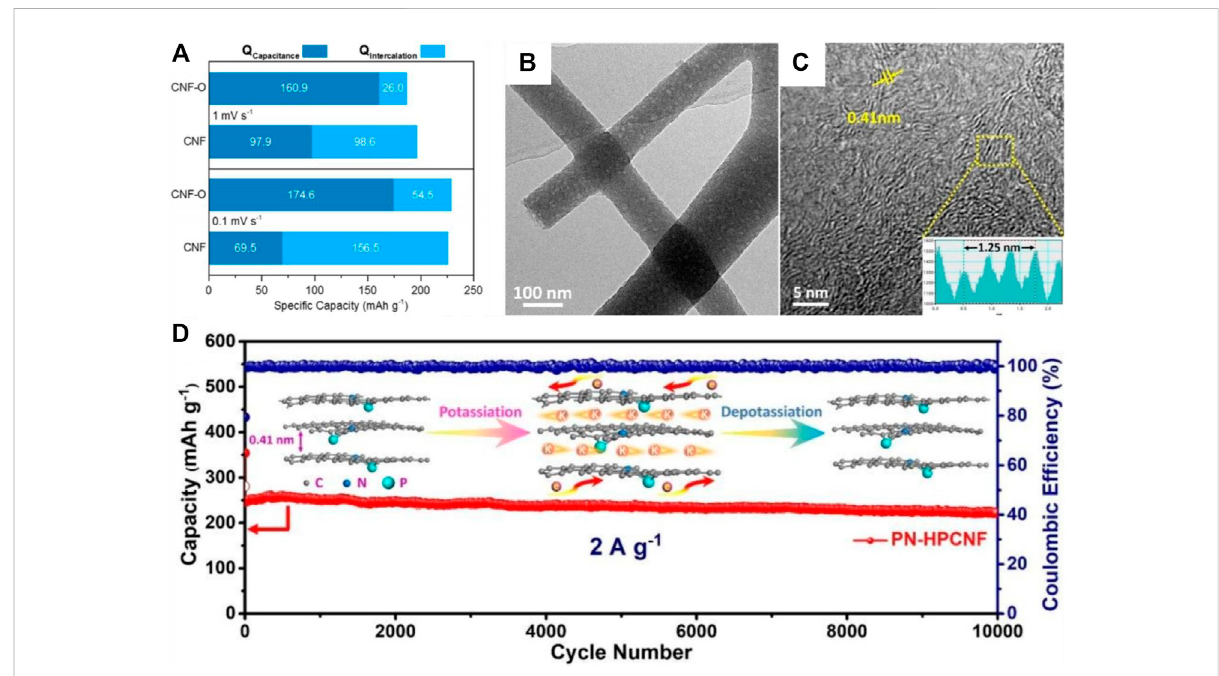
FIGURE 3 (A) Comparison of charge storage mechanism from intercalation and capacitance contributions for CNF and CNF-O at 0.1 and 1 mV s − 1 scan rates (Adams et al., 2017). (B) TEM image of PN-CNF. (C) HRTEM image of PN-HPCNF. (D) Long-term cycling performance of the PN-HPCNF at 2.0 A g − 1 (Hu et al., 2020)